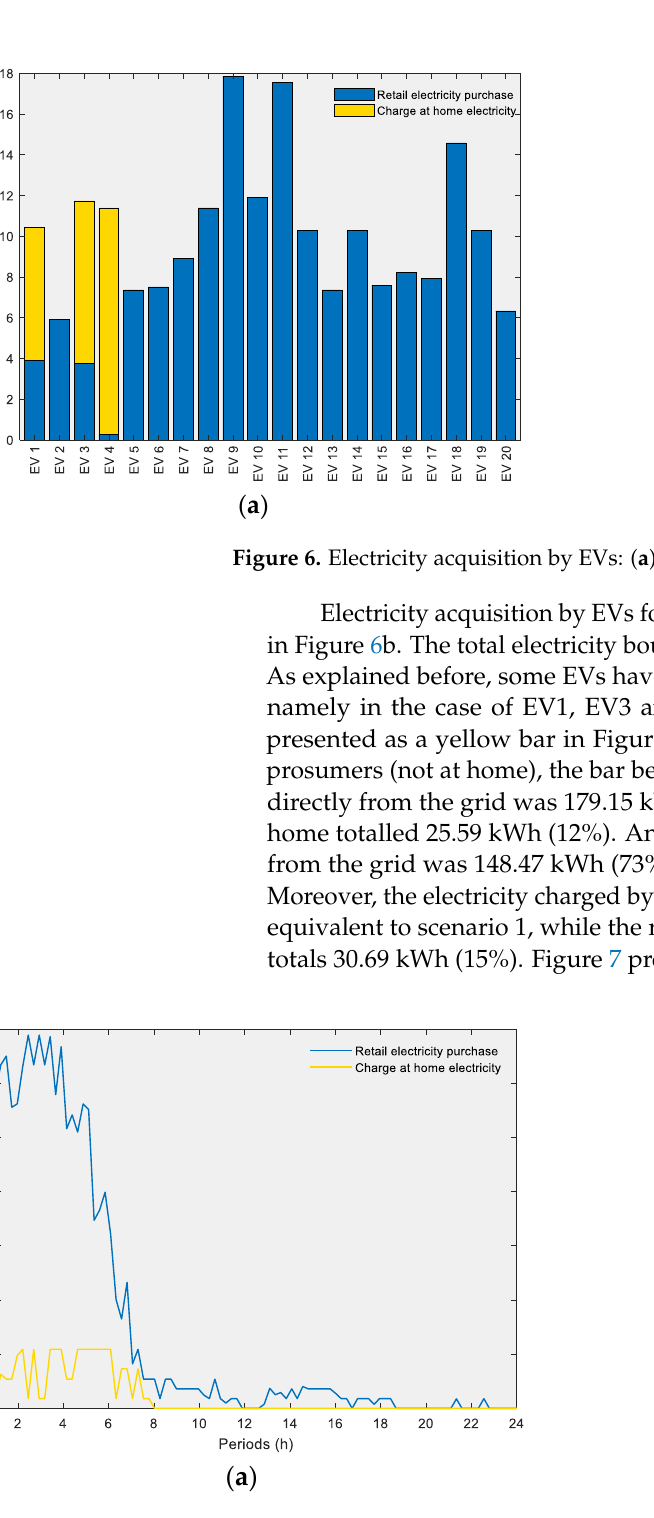
( b ) Figure 5. Electricity exported (grid and P2V transactions): ( a ) Scenario 1 and ( b ) Scenario 2. By analysing Figure 5a,b, a comparison between scenario 1 and scenario 2 can be made concerning the total electricity export. As can be seen when the P2V market was available, the amount of electricity that prosumers exported was relatively higher. In sce- nario 1, the prosumers exported 22.52 kW, and in scenario 2, they exported 35.48 kW. The